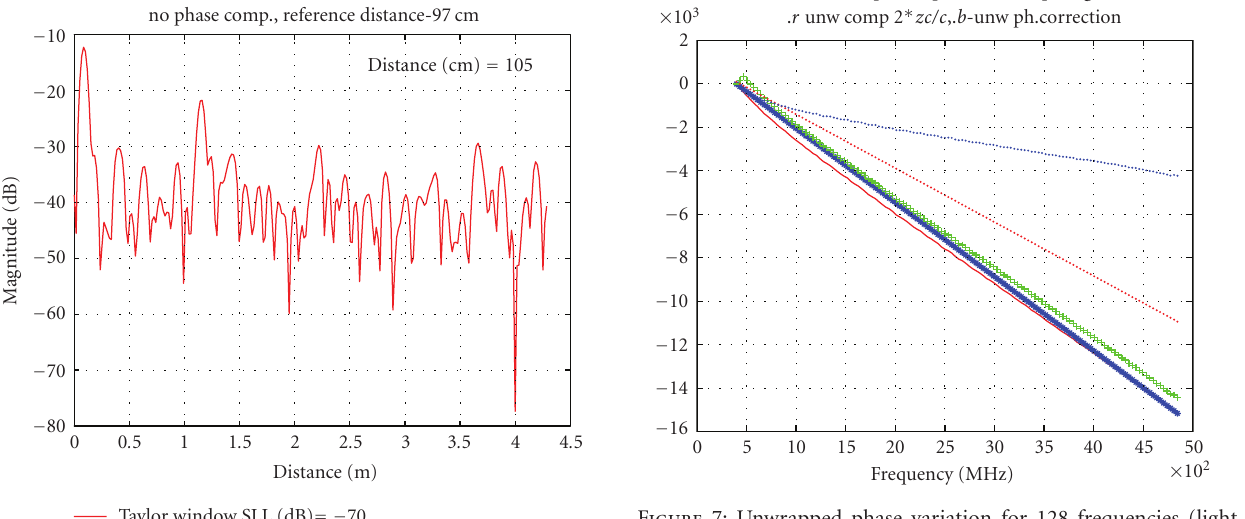
Figure 7: Unwrapped phase variation for 128 frequencies (light red: measured; dark blue: linearized; green: unwrapped with Matlab function; light red: due to propagation; light blue: phase